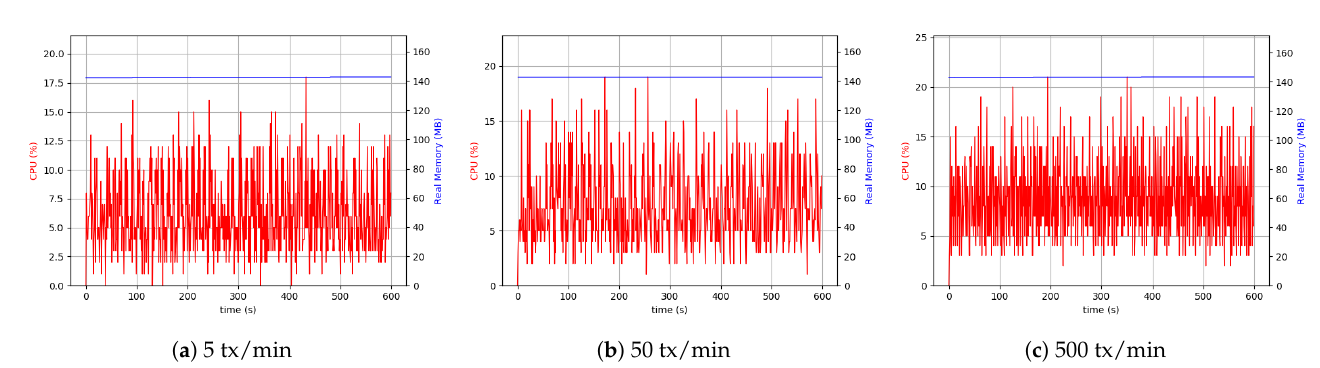
Figure 14. CPU and memory use for varying data sizes for peer process in RPi setup.